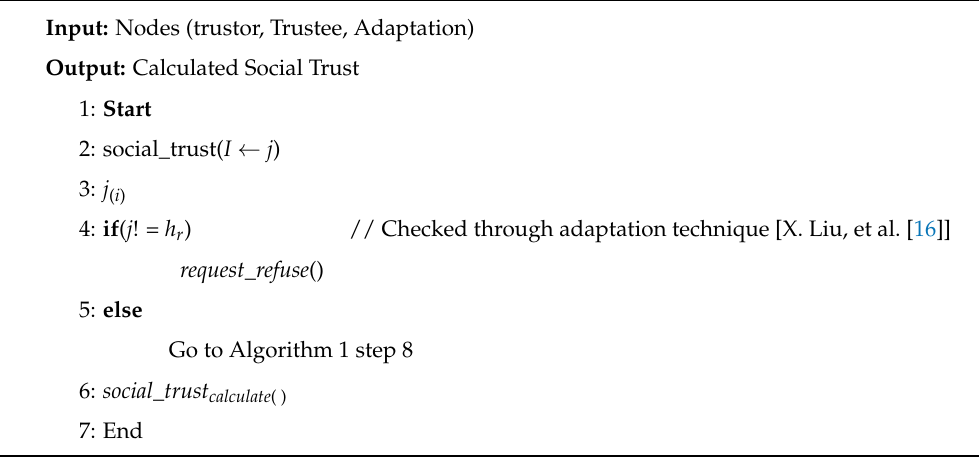
Algorithm 3. Social Trust Adaptation Technique.